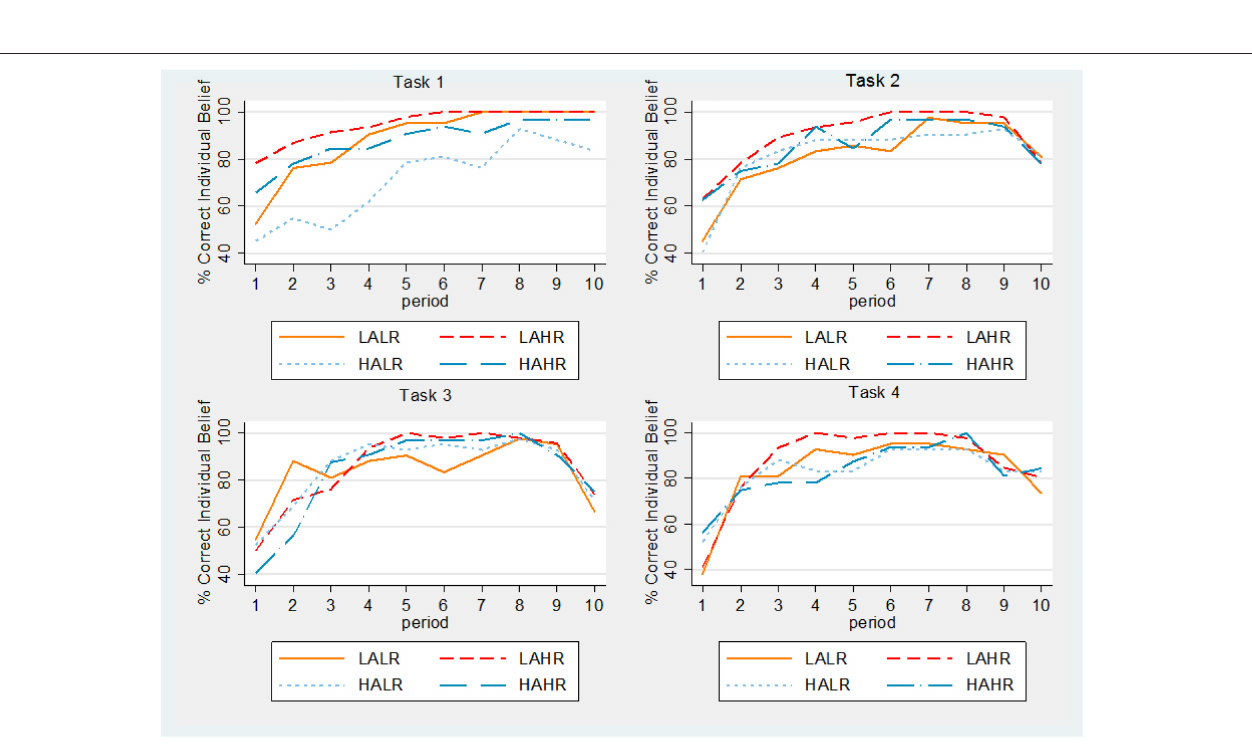
FIGURE 4 | Percentage of correct individual beliefs by task, period and